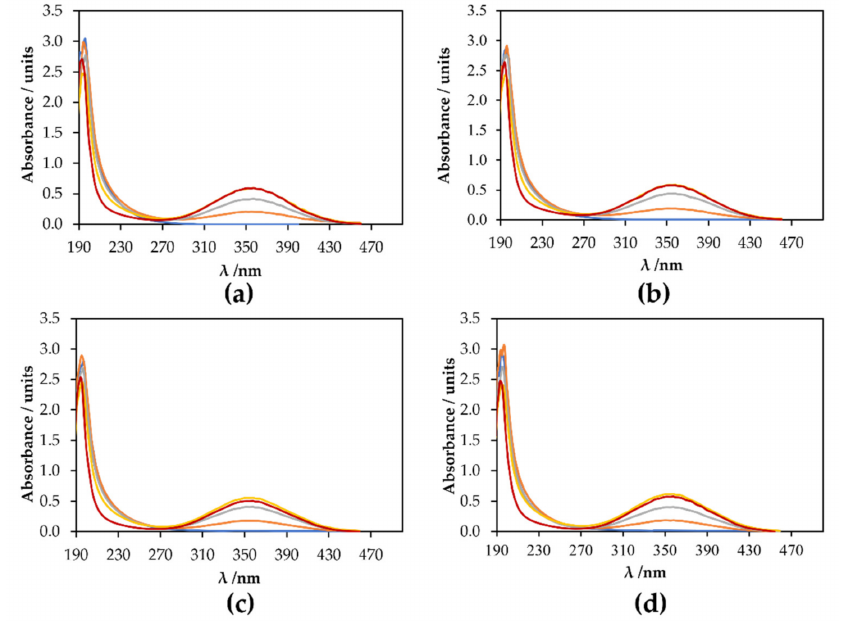
Figure 7. UV-vis spectra of samples (liquid phase) taken at different reaction times during the four Figure 1. UV-vis spectra ( a ) and deconvoluted UV-vis spectra lines ( b ) of samples containing H 2 SO 4 Figure 1. UV-vis spectra ( a ) and deconvoluted UV-vis spectra lines ( b ) of samples containing H 2 SO 4 Figure 1. UV-vis spectra ( a ) and deconvoluted UV-vis spectra lines ( b ) of samples containing H 2 SO 4 Figure 1. UV-vis spectra ( a ) and deconvoluted UV-vis spectra lines ( b ) of samples containing H 2 SO 4 Figure 1. UV-vis spectra ( a ) and deconvoluted UV-vis spectra lines ( b ) of samples containing H 2 SO 4 tests carried out ( a ) test1; ( b ) test 2; ( c ) test 3; ( d ) test 4. ( 5 M ( 25AC ), ClO 3 − 4.7 mM ( ▬ ), HClO 6.7 mM ( ▬ ), ClO − 5.4 mM ( ▬ ), chlorite 1.5 mM ( ▬ ). ) 0 h, ( 5 M ( 25AC ), ClO 3 − 4.7 mM ( ▬ ), HClO 6.7 mM ( ▬ ), ClO − 5.4 mM ( ▬ ), chlorite 1.5 mM ( ▬ ). ) 1 h, ( 5 M ( 25AC ), ClO 3 − 4.7 mM ( ▬ ), HClO 6.7 mM ( ▬ ), ClO − 5.4 mM ( ▬ ), chlorite 1.5 mM ( ▬ ). ) 3 h, ( 5 M ( 25AC ), ClO 3 − 4.7 mM ( ▬ ), HClO 6.7 mM ( ▬ ), ClO − 5.4 mM ( ▬ ), chlorite 1.5 mM ( ▬ ). ) 9 h and ( 5 M ( 25AC ), ClO 3 − 4.7 mM ( ▬ ), HClO 6.7 mM ( ▬ ), ClO − 5.4 mM ( ▬ ), chlorite 1.5 mM ( ▬ ). ) 24